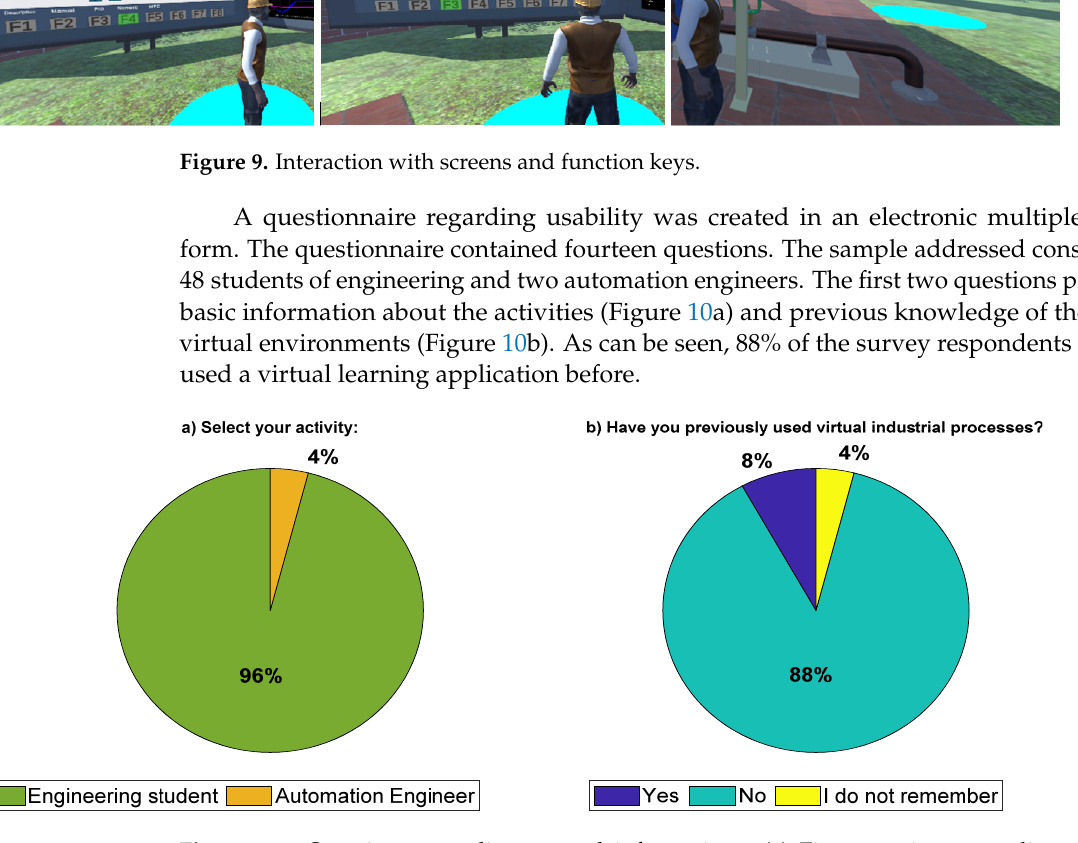
Figure 9. Interaction with screens and function